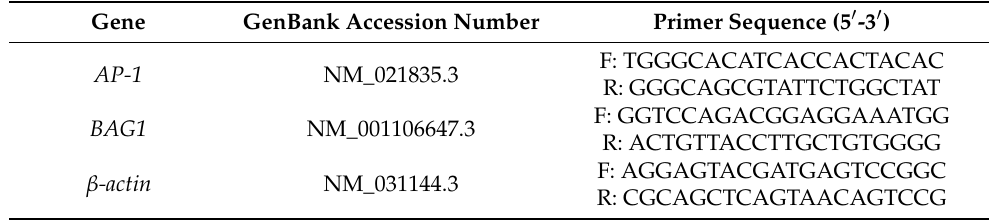
Table 1. Primers used for